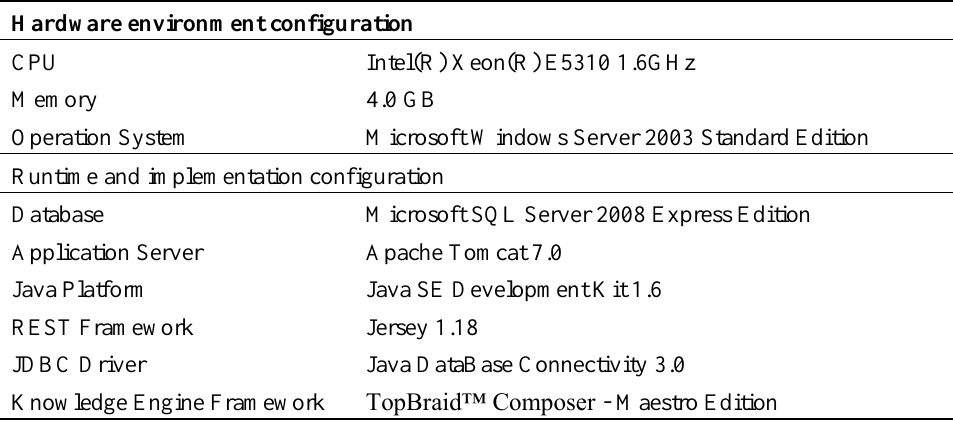
Table 6. UFIT Hardware and software